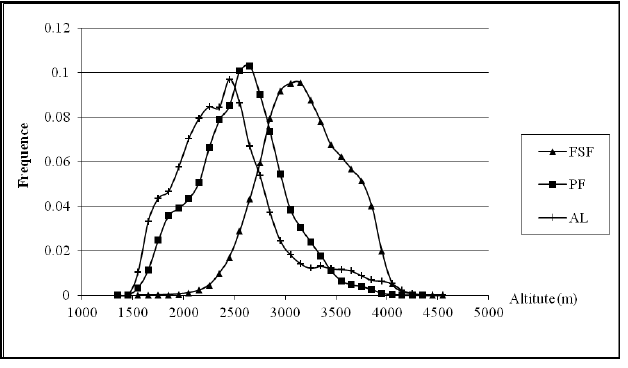
Figure 8. Frequency distribution of fir and spruce forest (FSF), pine forest (PF), and agricultural land (AL) obtained by ANN classification without DEM as an extra channel.